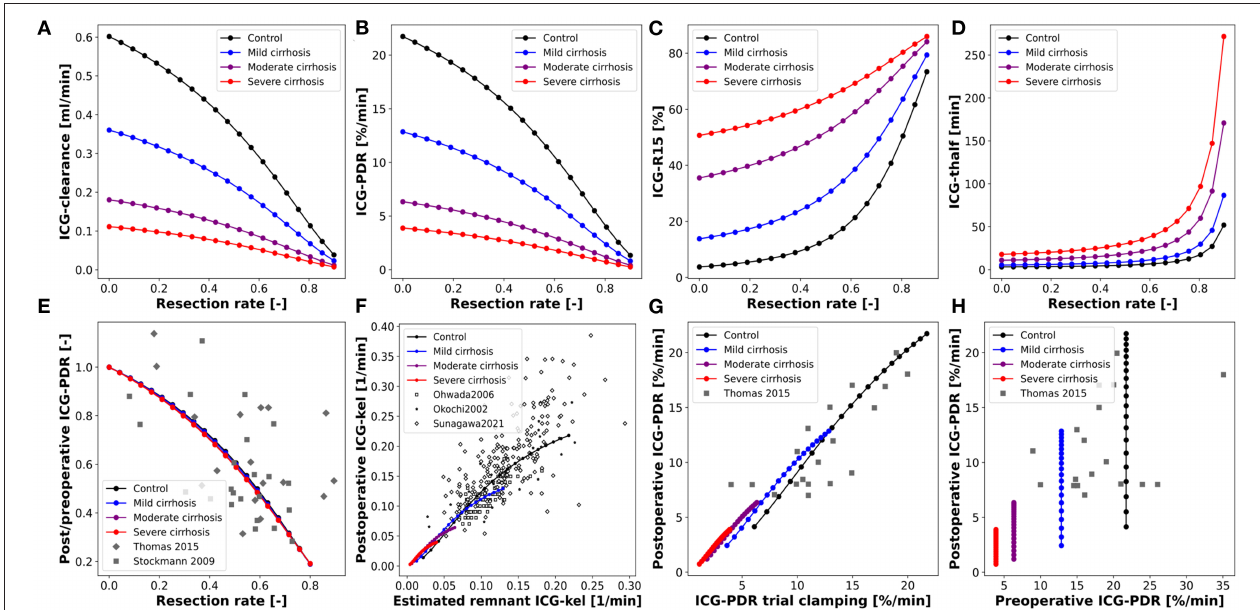
FIGURE 7 | Model prediction of ICG pharmacokinetic parameters in hepatectomy under varying degree of cirrhosis. (A–D) Dependency of postoperative ICG pharmacokinetic parameters on the resected volume in 4 different degrees of cirrhosis. (E) Dependency of postoperative change in ICG-PDR on the resected volume ( Stockmann et al., 2009; Thomas et al., 2015). (F) Correlation between the measured postoperative ICG-kel and the estimated postoperative ICG-kel (product of preoperative ICG-kel and the future liver remnant) ( Okochi et al., 2002; Ohwada et al., 2006; Sunagawa et al., 2021). (G) Correlation between postoperative